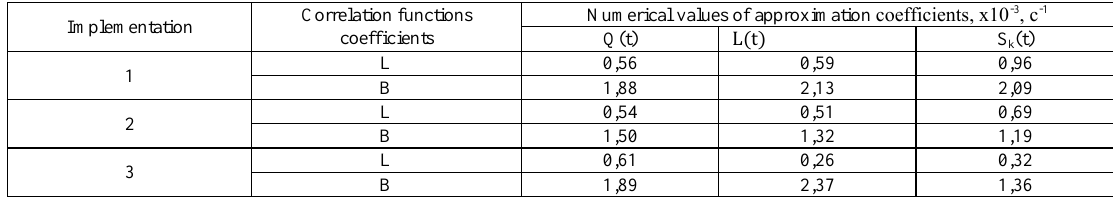
Table 2. Approximation coefficients of the processes correlation functions of changing the productivity